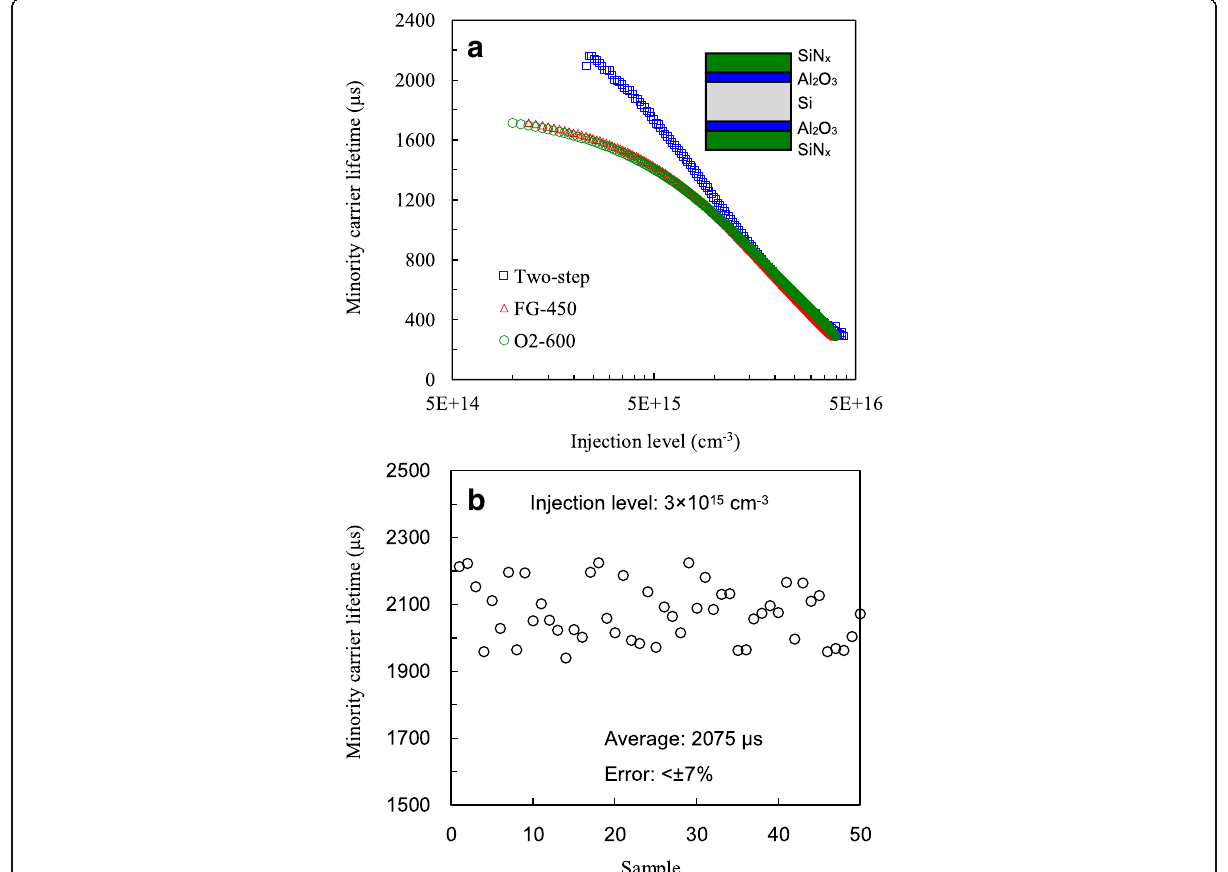
Fig. 5 a Injection-level-dependent minority carrier lifetime of SiN x /Al 2 O 3 -passivated samples with O 2 , FG, and two-step annealing. b Lifetime at an injection level of 3 × 10 15 cm − 3 for 50 samples with two-step